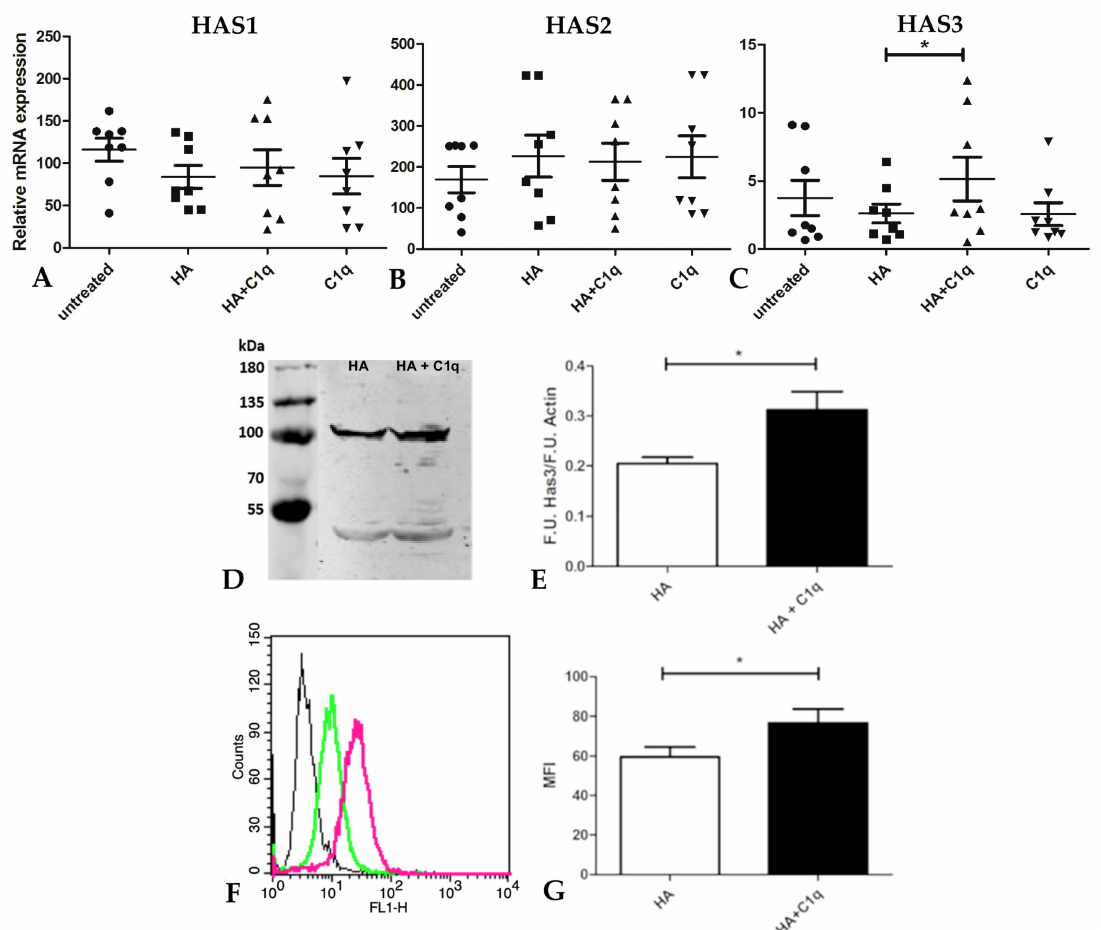
Figure 7. HAS modulation in MPM primary cells after treatment with C1q and/or HA. ( A – C ) C1q and/or HA were immobilized as a matrix and MPM primary cells, after ON incubation, were analyzed by quantitative real-time PCR, highlighting upregulation of HAS3 mRNA expression level. Data were expressed as the means of experiments performed on eight different MPM populations in triplicates ± SEM, * p < 0.05. ( D , E ) Western blot analysis of HAS3 expression in MPM primary cells seeded onto HA or the HA and C1q matrix. Cell lysates were separated by SDS-PAGE and, after the transfer process, the membrane was probed with the α -HAS3 primary antibody and a LI-COR IRDye secondary antibody. Fluorescence intensity was identified using an Odyssey ® CLx near-infrared scanner (LI-COR Biosciences, Lincoln, NE, USA). Image acquisition, processing and data analysis were performed with Image Studio ver 5.2 (LI-COR Biosciences). B-actin was used to normalize the results, * p < 0.05. ( F , G ) Cytofluorimetric analysis of HAS3 expression after the HA (green line) or the HA and C1q (magenta line) treatment. Fluorescence intensity of the cells incubated with the HAS3 primary antibody was compared with unrelated staining (black line). Upregulation of HAS3 at the protein level was confirmed in MPM cells, * p <